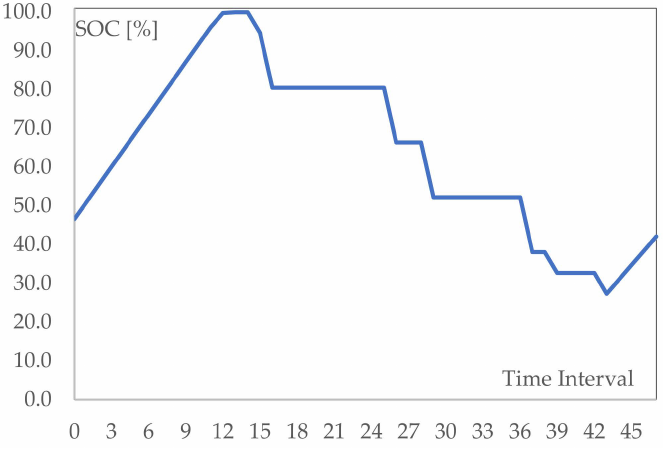
Figure 6. SOC profile for mobility pattern 2.